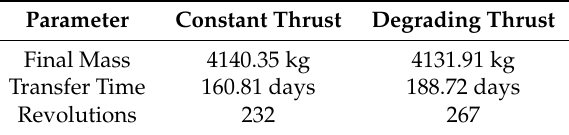
Table 4. Algorithm performance comparison with neural network and coasting mode ON for GTO to GEO